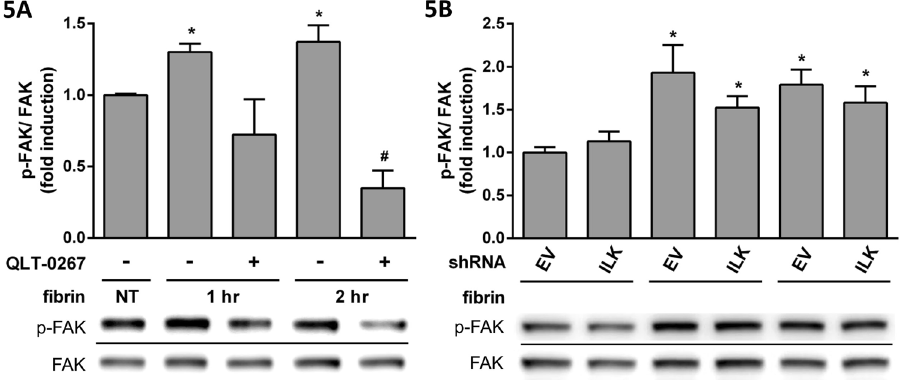
Figure 5. PMCs were overlaid with fibrin via incubation with a fibrinogen and thrombin mixture for 0, 1 and 2 hr. The effect of QLT-0267 treatment on p-FAK expressions was evaluated in triplicate by Western blotting. ( A ) The relative expressions of p-FAK vs. FAK are presented as a percentage of increase over untreated PMCs (NT). PMCs infected with lentiviruses carrying either shILK (ILK) or an empty vector (EV) control were overlaid with fibrin via incubation with a fibrinogen and thrombin mixture for 0, 1 and 2 hr. p-FAK expression was evaluated in triplicate by Western blotting. ( B ) The relative expression of p-FAK vs. FAK is presented as percentage of increase over NT. * P < 0.05 vs. NT; # P < 0.05 vs. fibrin only at the same incubation time.